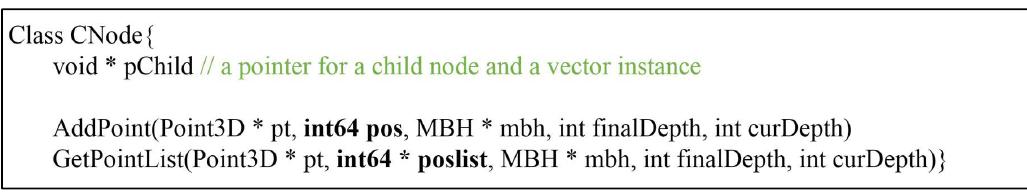
Figure 4. Pseudo codes of a revised form CNode using a file-pointer.